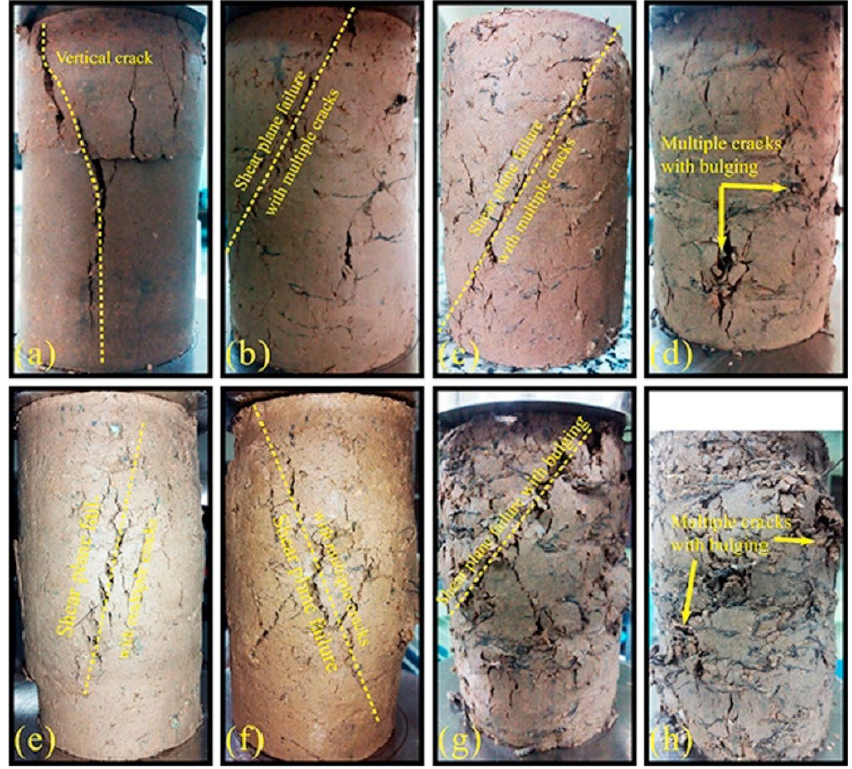
Figure 4. Typical failure patterns under UCS tests: ( a ) CF0, ( b ) CF0.5, ( c ) CF1, ( d ) CF4, ( e ) SF0, ( f ) SF0.5, ( g ) SF3, ( h ) SF4 (clayey and sandy composites are coded as CFχ and SFχ , respectively, where χ represents the weight ratio of WTTF to dry soil) [37].